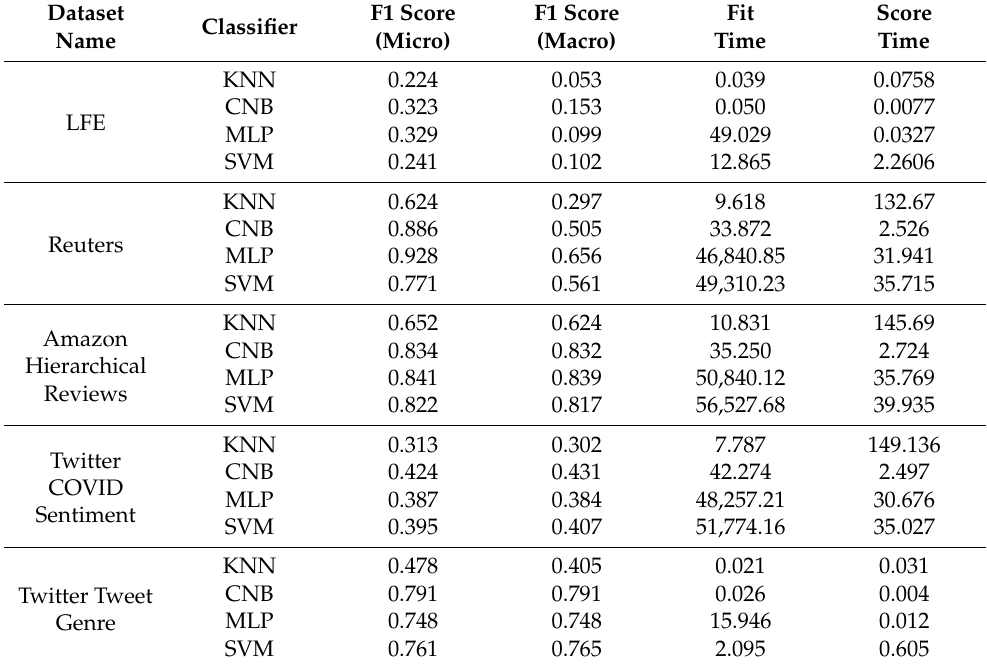
Table 5. Evaluates the use of different classifiers. The processing pipeline is maintained aside from word scoring (stop words removed, words lemmatized, additional text cleaning, TF-IDF, BoW).